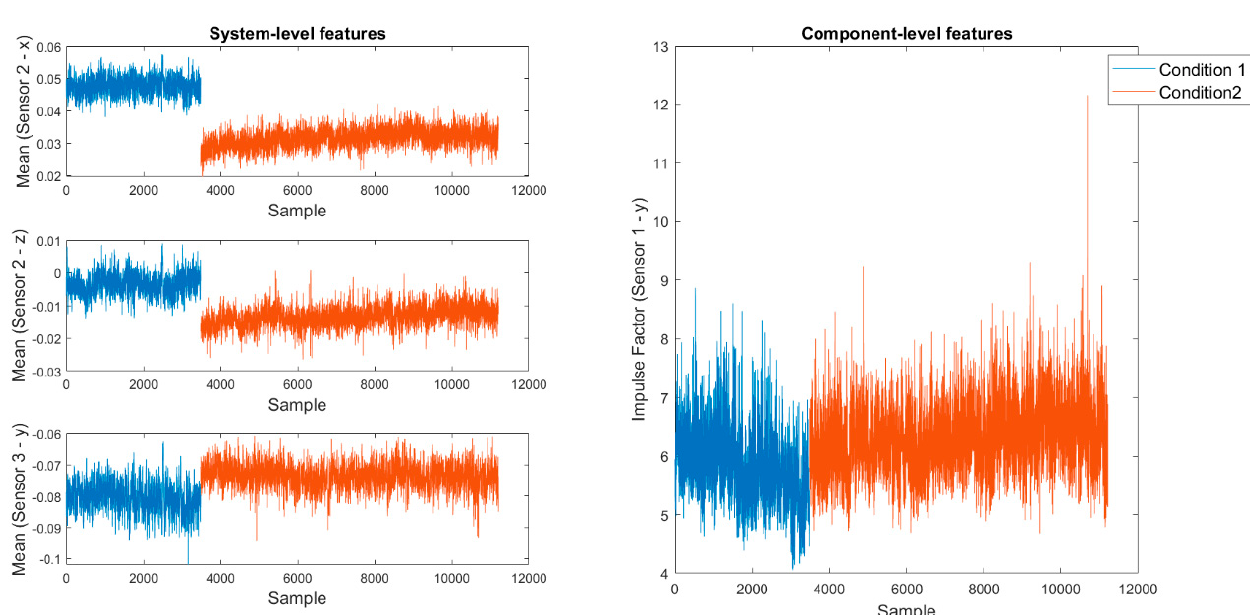
Figure 7. Selected system-level features ( left ) and component-level features ( right ).